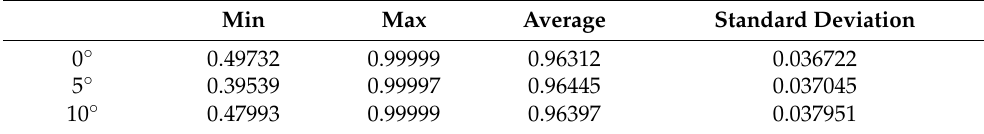
Table 2. The element quality of mesh metric.